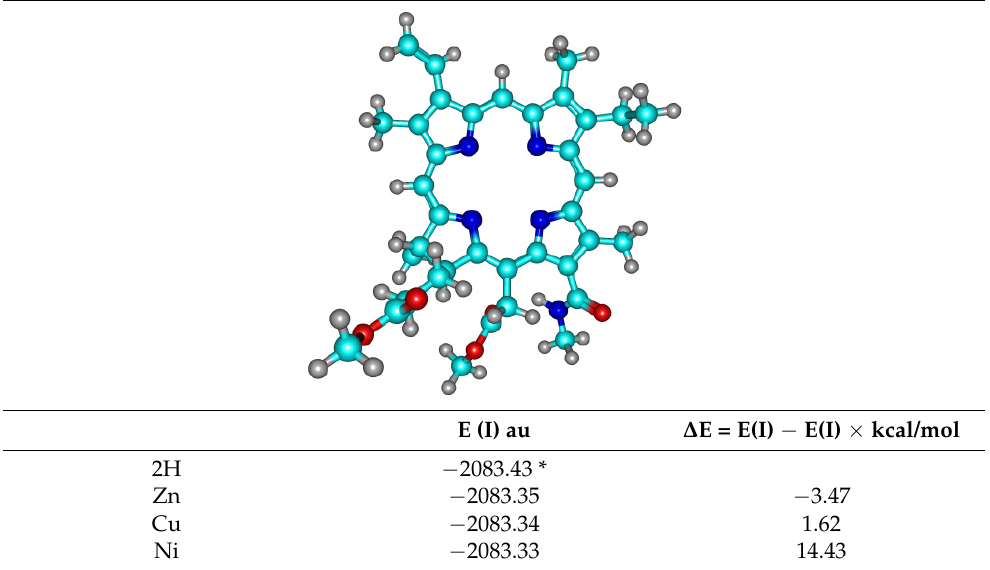
Table 4. Change in energy of the MADMECl dianion after complex formation.